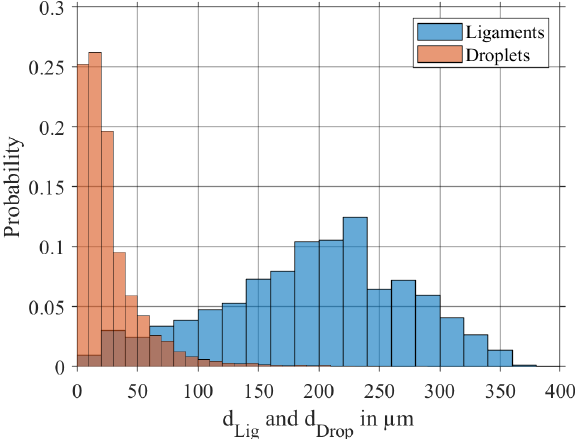
Figure 12. Ligament size and droplet diameter for p g = 5bar, u g = 70m/s, h a =